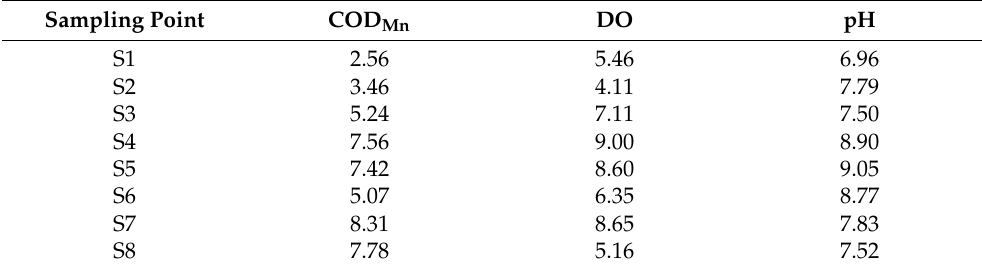
Table 3. The COD Mn , DO, and pH values of overlying water of the Yitong